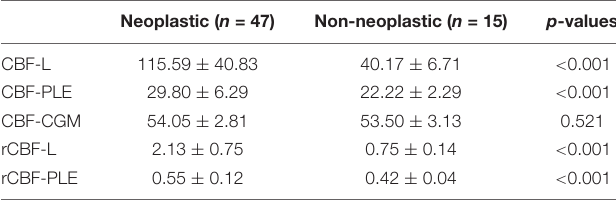
TABLE 2 | 3D-pCASL imaging-derived parameters for non-neoplastic and neoplastic. Neoplastic ( n = 47)